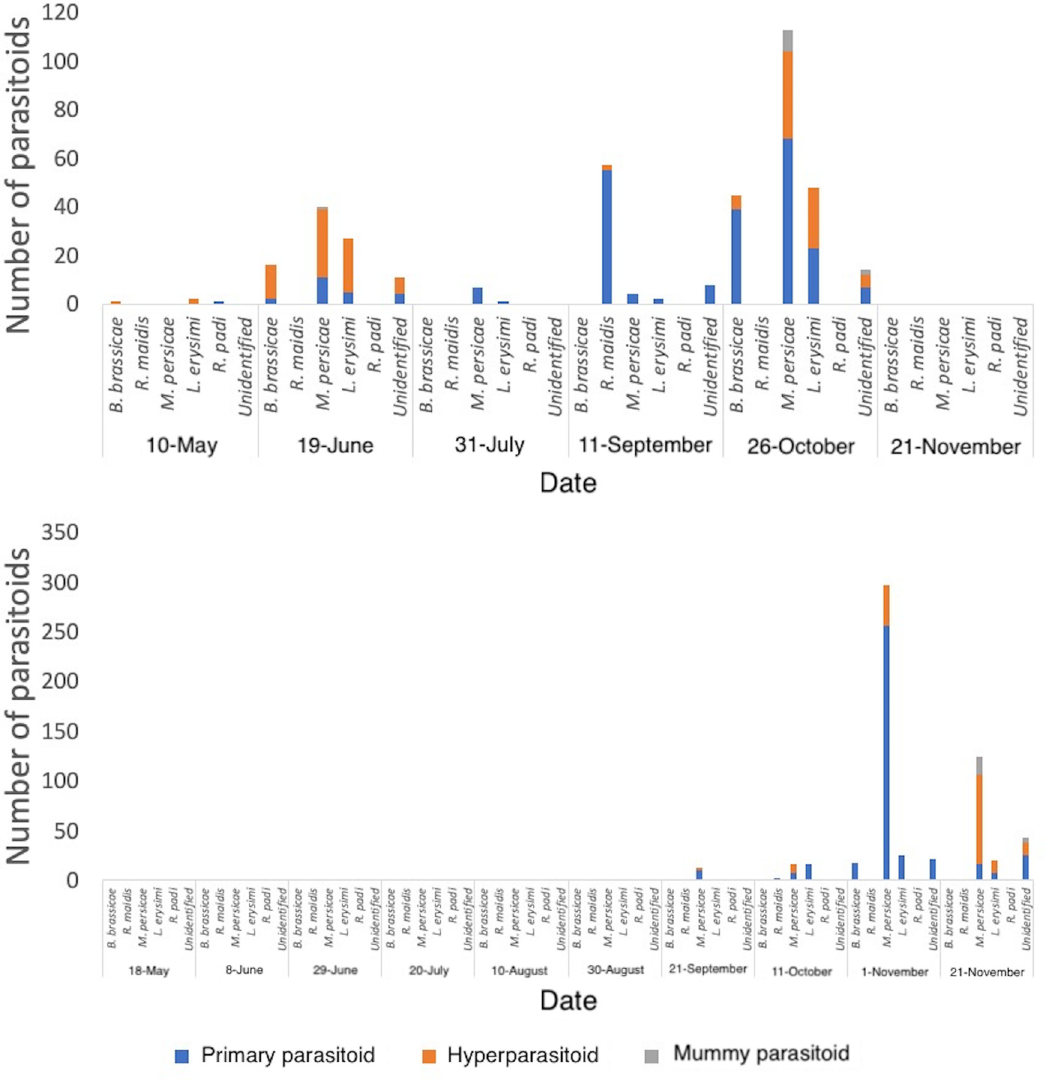
Figure 6. Number of mummies collected within and surrounding all fields in ( a ) 2017 and ( b ) 2018, within two minutes, along with the relative frequency at which primary parasitoids, hyperparasitoids, and mummy parasitoids